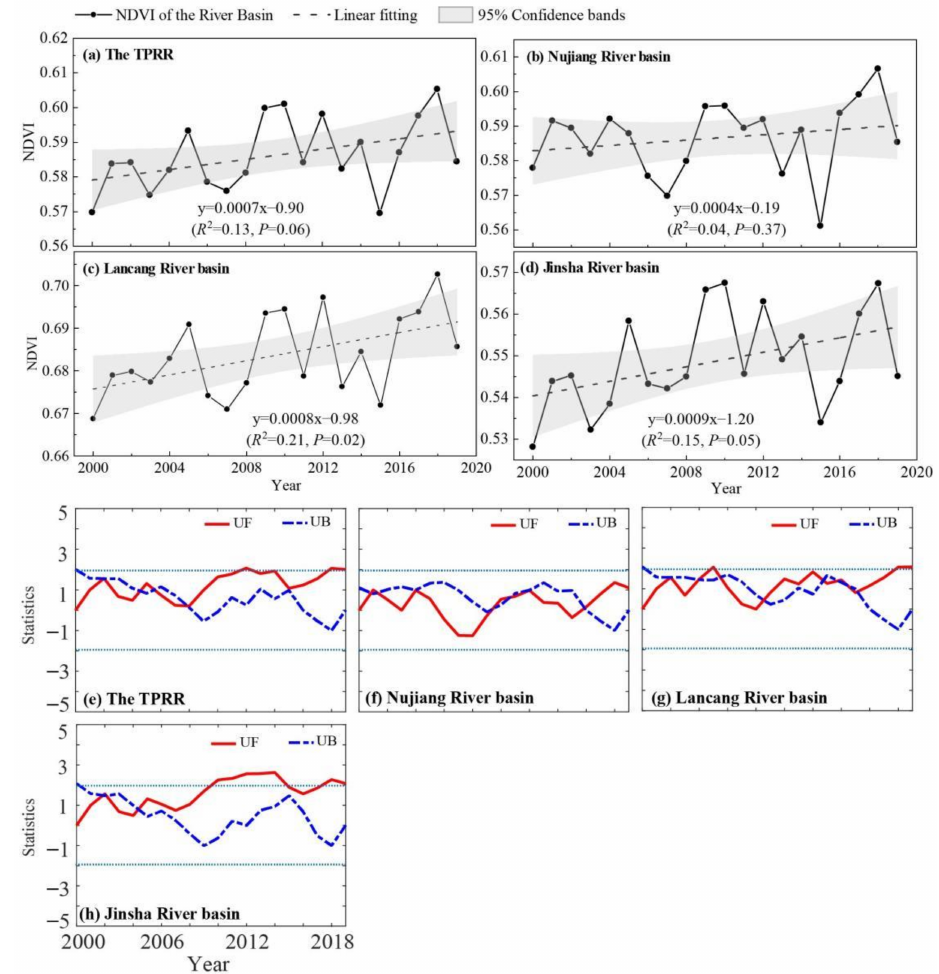
Figure 4. Inter-annual variation and Mann-Kendall test of NDVI in the basin from 2000 to 2019. ( a – d ) represent inter-annual NDVI variations in the TPRR and its sub-basins (Nujiang, Lancang and Jinsha river basins, respectively), while ( e – h ) represent the M-K results of them. The mean NDVI in the basin tended to increase and then decrease with increasing elevation, and its value reached the maximum at 3000 m (about 0.80) and the minimum at 5500 m (about 0.05) (Figure S1a). Vegetation in the area below 2500 m was dominated by high vegetation cover, mainly in the southern part of the region, and the vegetation types were mainly cropland and evergreen coniferous forest (Table S2). Besides, the spatial distribution of mean NDVI in different elevation zones showed that regional vegetation was affected by elevation showing significant north-south differences (Figure S2a). The proportion of area occupied by each class indicated that the vegetation cover of all elevation zones is dominated by high vegetation cover, especially in the southern regions of the TPRR and in its core area (Figure 5). However, as the elevation continued to rise, NDVI started to decline from 4500 m, and the vegetation cover gradually transitions from low vegetation cover to unvegetated snow-capped mountain